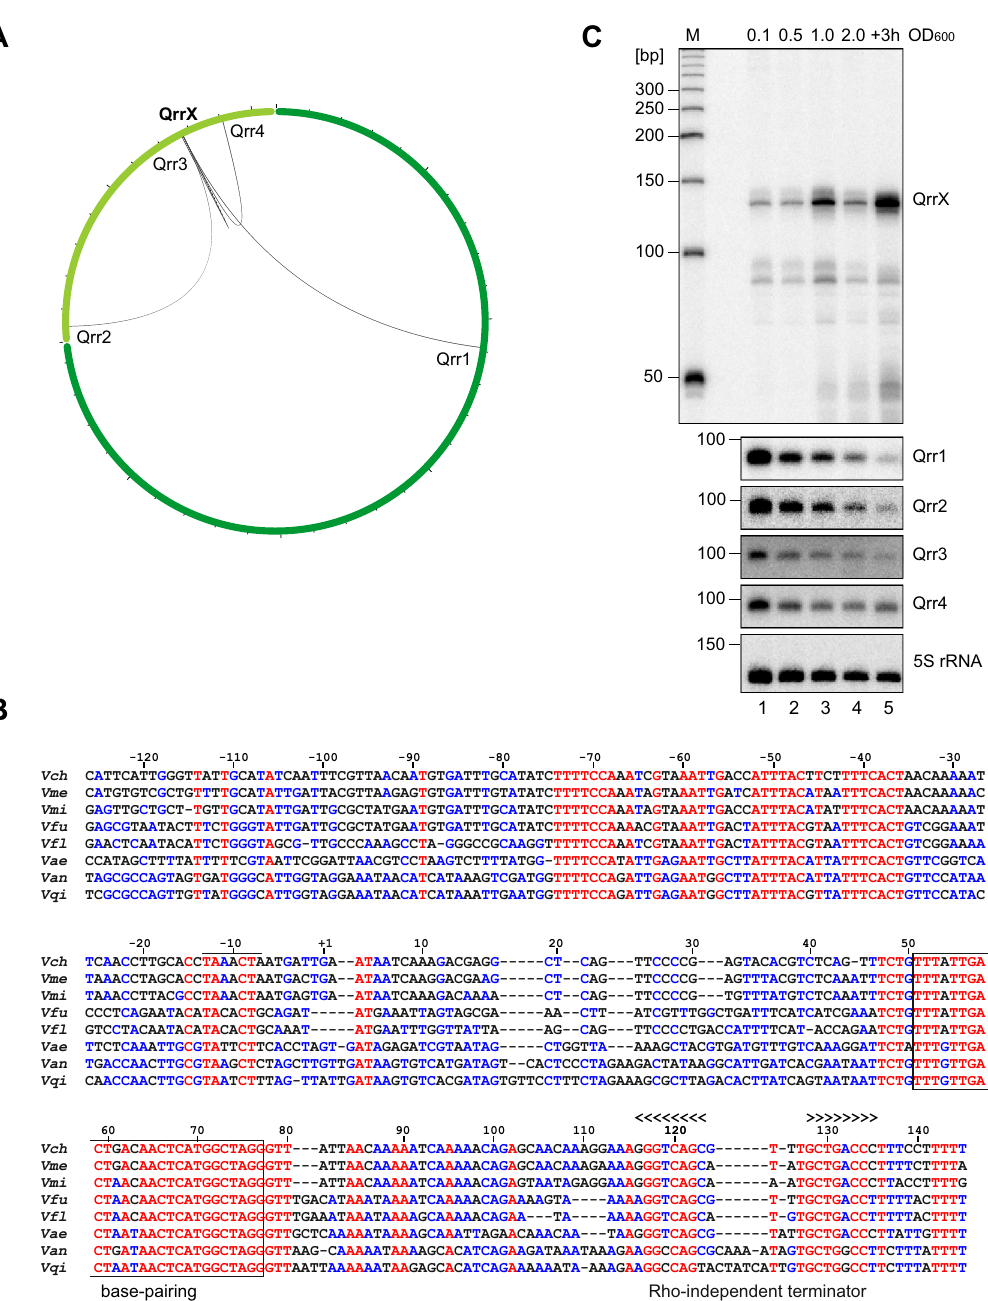
Fig. 2 | Identi fi cationofQrrX spongeRNA. A Interaction partnersof QrrX. Circos plot visualizing interaction partners of QrrXidenti fi ed byRIL-seq.The fi rst and the second chromosome are marked in dark and light green, respectively. Circos plot wasgeneratedusingthecircoscomponentoftheDashBiopackage. B Alignmentof qrrX sequences from various Vibrio species. The qrrX sequences including the promotor regions were aligned using the Multalin tool 65 . The predicted base- pairing region and the Rho-independent terminator are indicated. Numbers above the sequences indicate the distance to the transcriptional start site. Vch , Vibrio